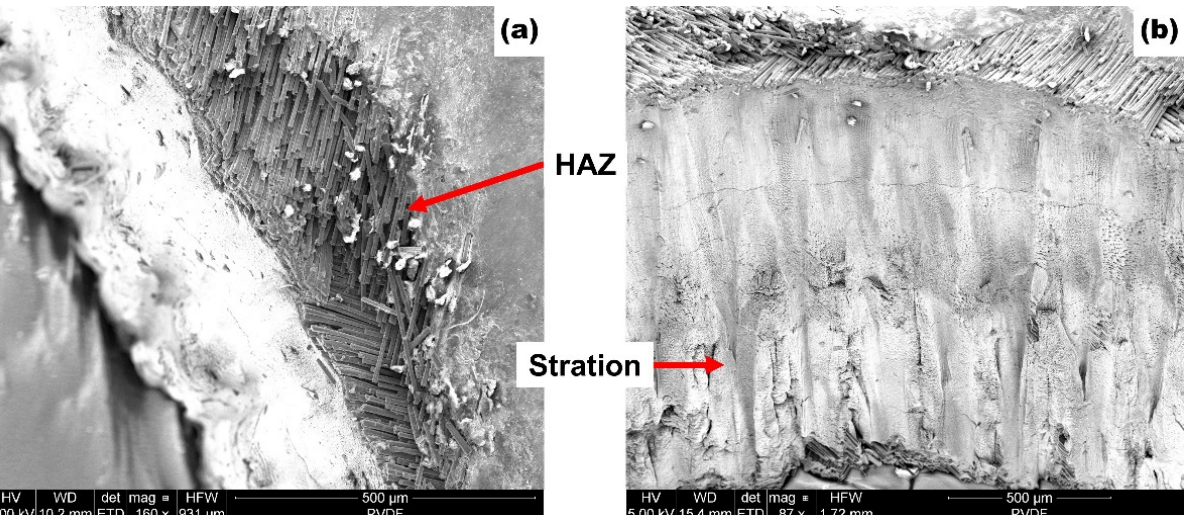
Figure 10. Optical images of CFRP workpieces drilled via the following different methods: ( a ) stepped laser parameter multiple-ring drilling method; ( b ) constant laser parameter multiple-ring drilling method.